Question: Identify the chart type used in this figure.
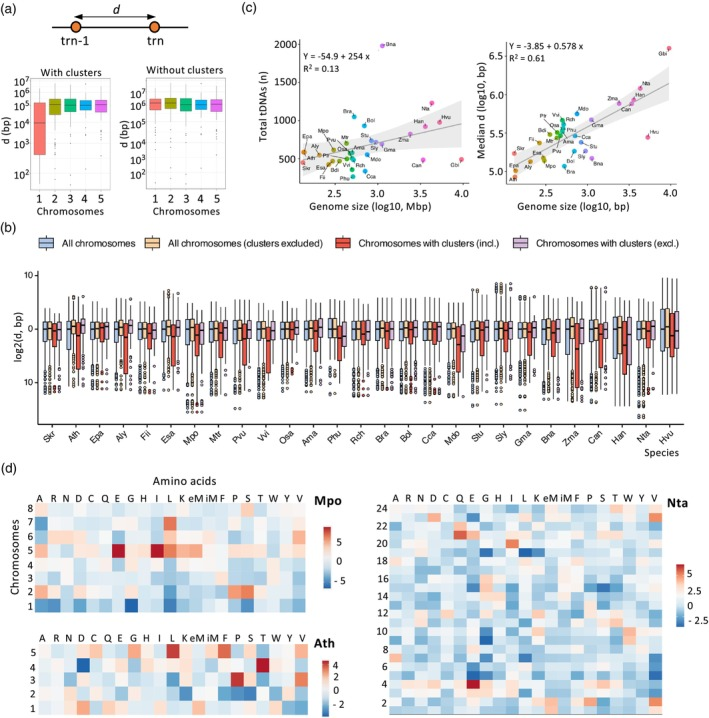
Answer: heatmap